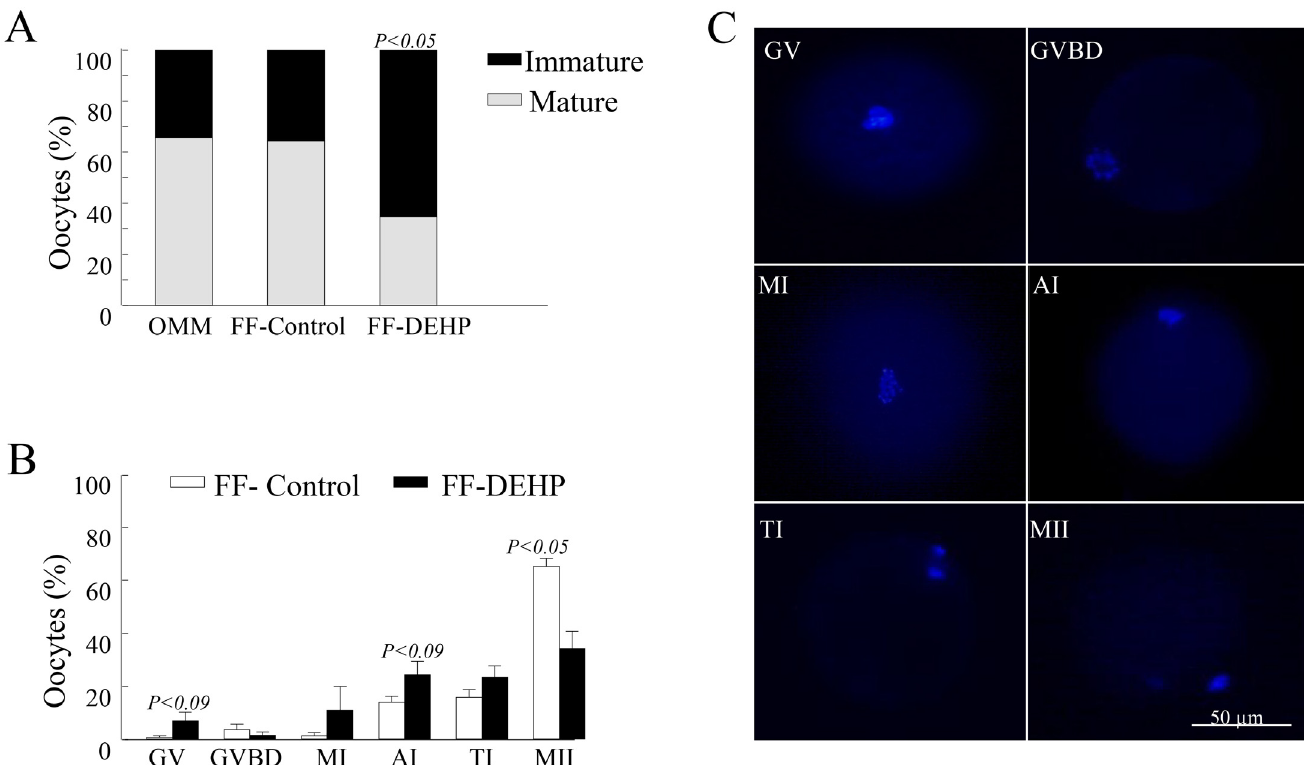
Fig 7. Nuclear maturation of oocytes cultured in follicular fluid (FF) aspirated from control (FF-control) and DEHP-treated (FF-DEHP) cows, or in oocyte maturation medium (OMM). At the end of maturation, oocytes were denuded and stained with DAPI to evaluate their meiotic status. (A) Proportion of oocytes at MII stage (i.e., mature) or at earlier meiotic stages (i.e., immature) calculated out of total oocytes; P -value indicates treatment effect within maturation stages between experimental groups. (B) Distribution of oocytes into meiotic stages. Data are presented as means ± SEM; P -value indicates treatment effect within meiotic stages between experimental groups: germinal vesicle (GV); GV breakdown (GVBD); metaphase I (MI); anaphase I (AI); telophase I (TI), and metaphase II (MII). (C) Representative images of oocytes at different meiotic stages: